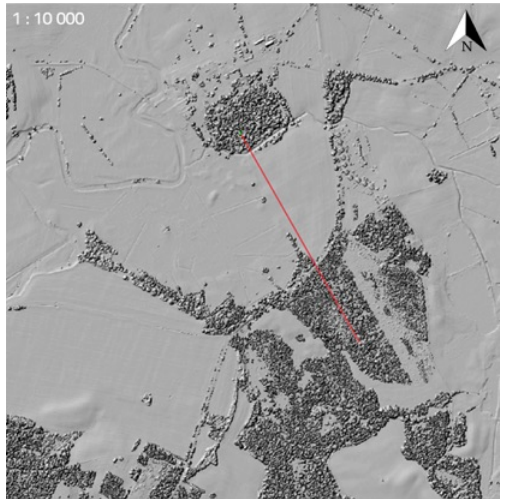
Figure 11a. Line of sight starting at the Palace in Rapa running in the direction of the Pyramid presented on the Digital Surface Model – any portions in red indicated that the line of sight is obstructed ( ArcMap, Esri );